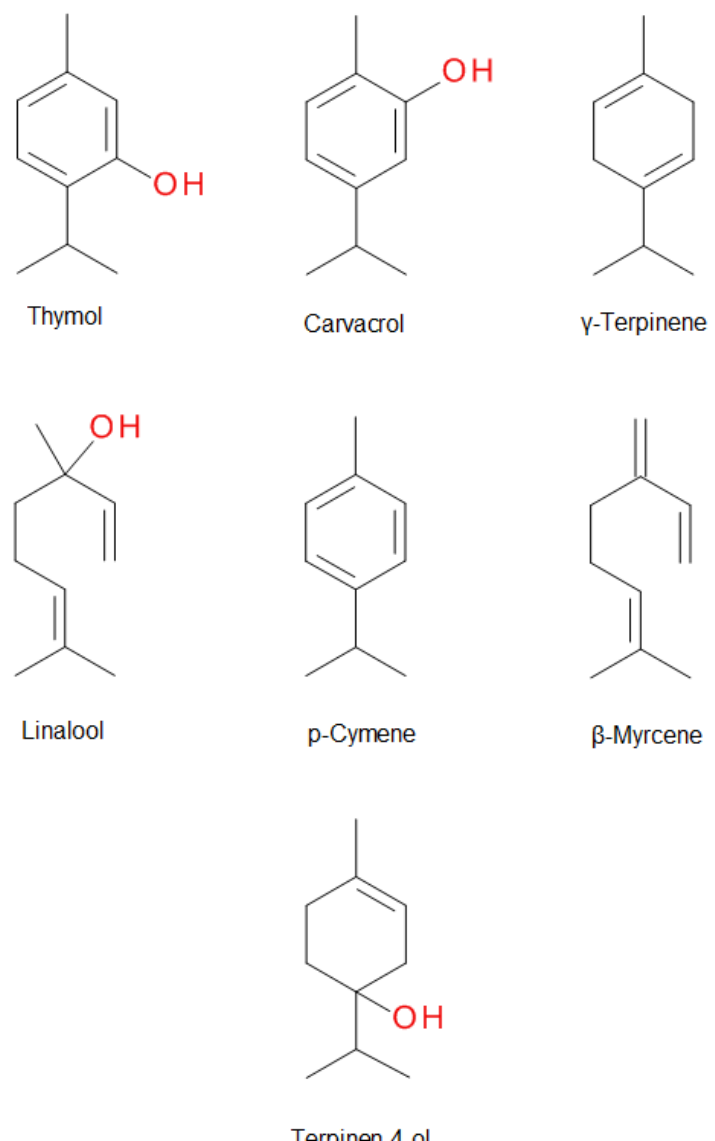
Figure 2. The structure of the main components of thyme essential oil.